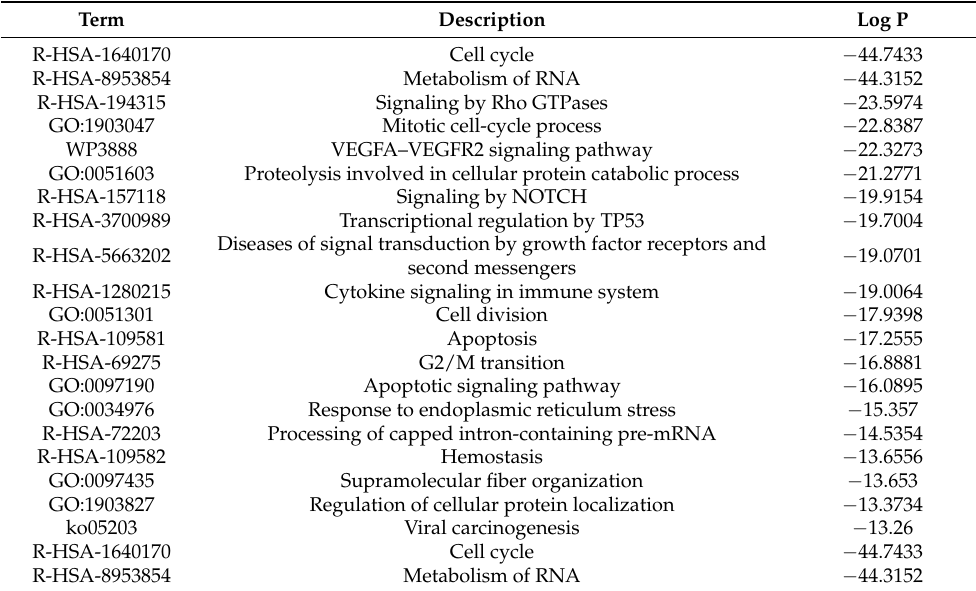
Figure 4. Heatmap, Venn diagram, and KEGG pathway enrichment of significantly altered expression of RNA transcripts for promoter analysis. ( A , B ) Heatmap diagrams showed the significantly changed mRNA (fold change >10 and FPKM > 10) and lncRNA (fold change > 5 and FPKM > 5) transcripts upon H 2 O 2 treatment in HPNE cells ( A ) and PANC-1 cells ( B ). ( C ) Gene loci of significantly changed transcripts under H 2 O 2 treatment in both cell lines. The differentially expressed RNA transcripts in the four groups (two cell lines treated with or without H 2 O 2 as indicated) were analyzed by Venn diagram. The overlapping region for all samples contained two genes (PKM and PSMA6). ( D ) Histogram of the top 20 GO enrichment terms for significantly changed transcripts upon H 2 O 2 treatment in both cell lines, generated using the Metascape tool. The detailed description of terms is shown in Table 1. Table 1. Description and log p ‐ value of KEGG enrichment terms in Figure 3C.